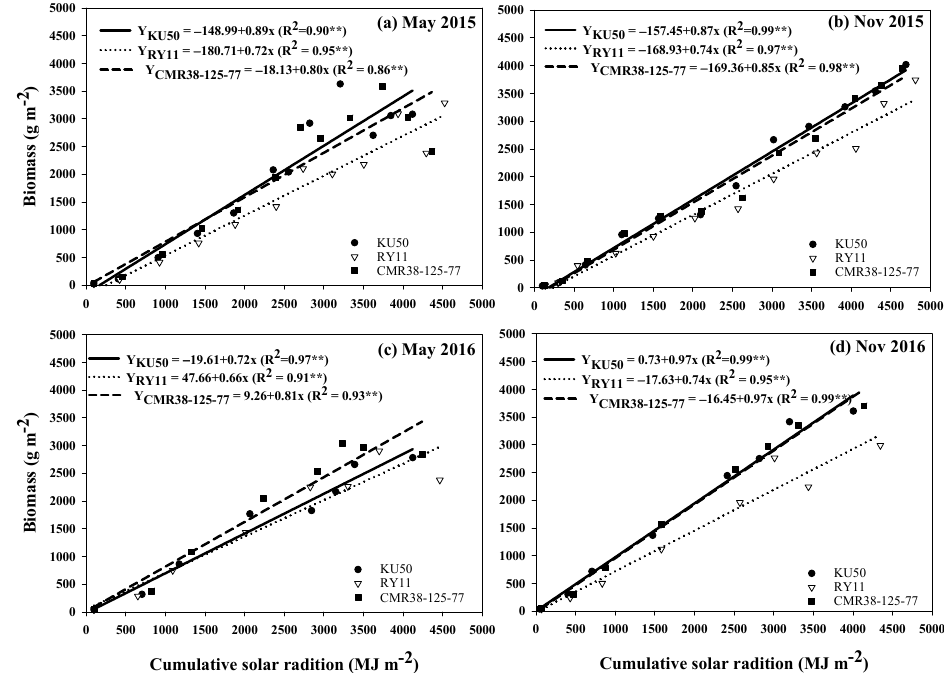
Figure 5. Regression analysis for biomass and cumulative solar radiation of 3 cassava genotypes planted in May and November 2015 ( a , b ) and 2016 ( c , d ). **= significant at p < 0.01 probability levels.